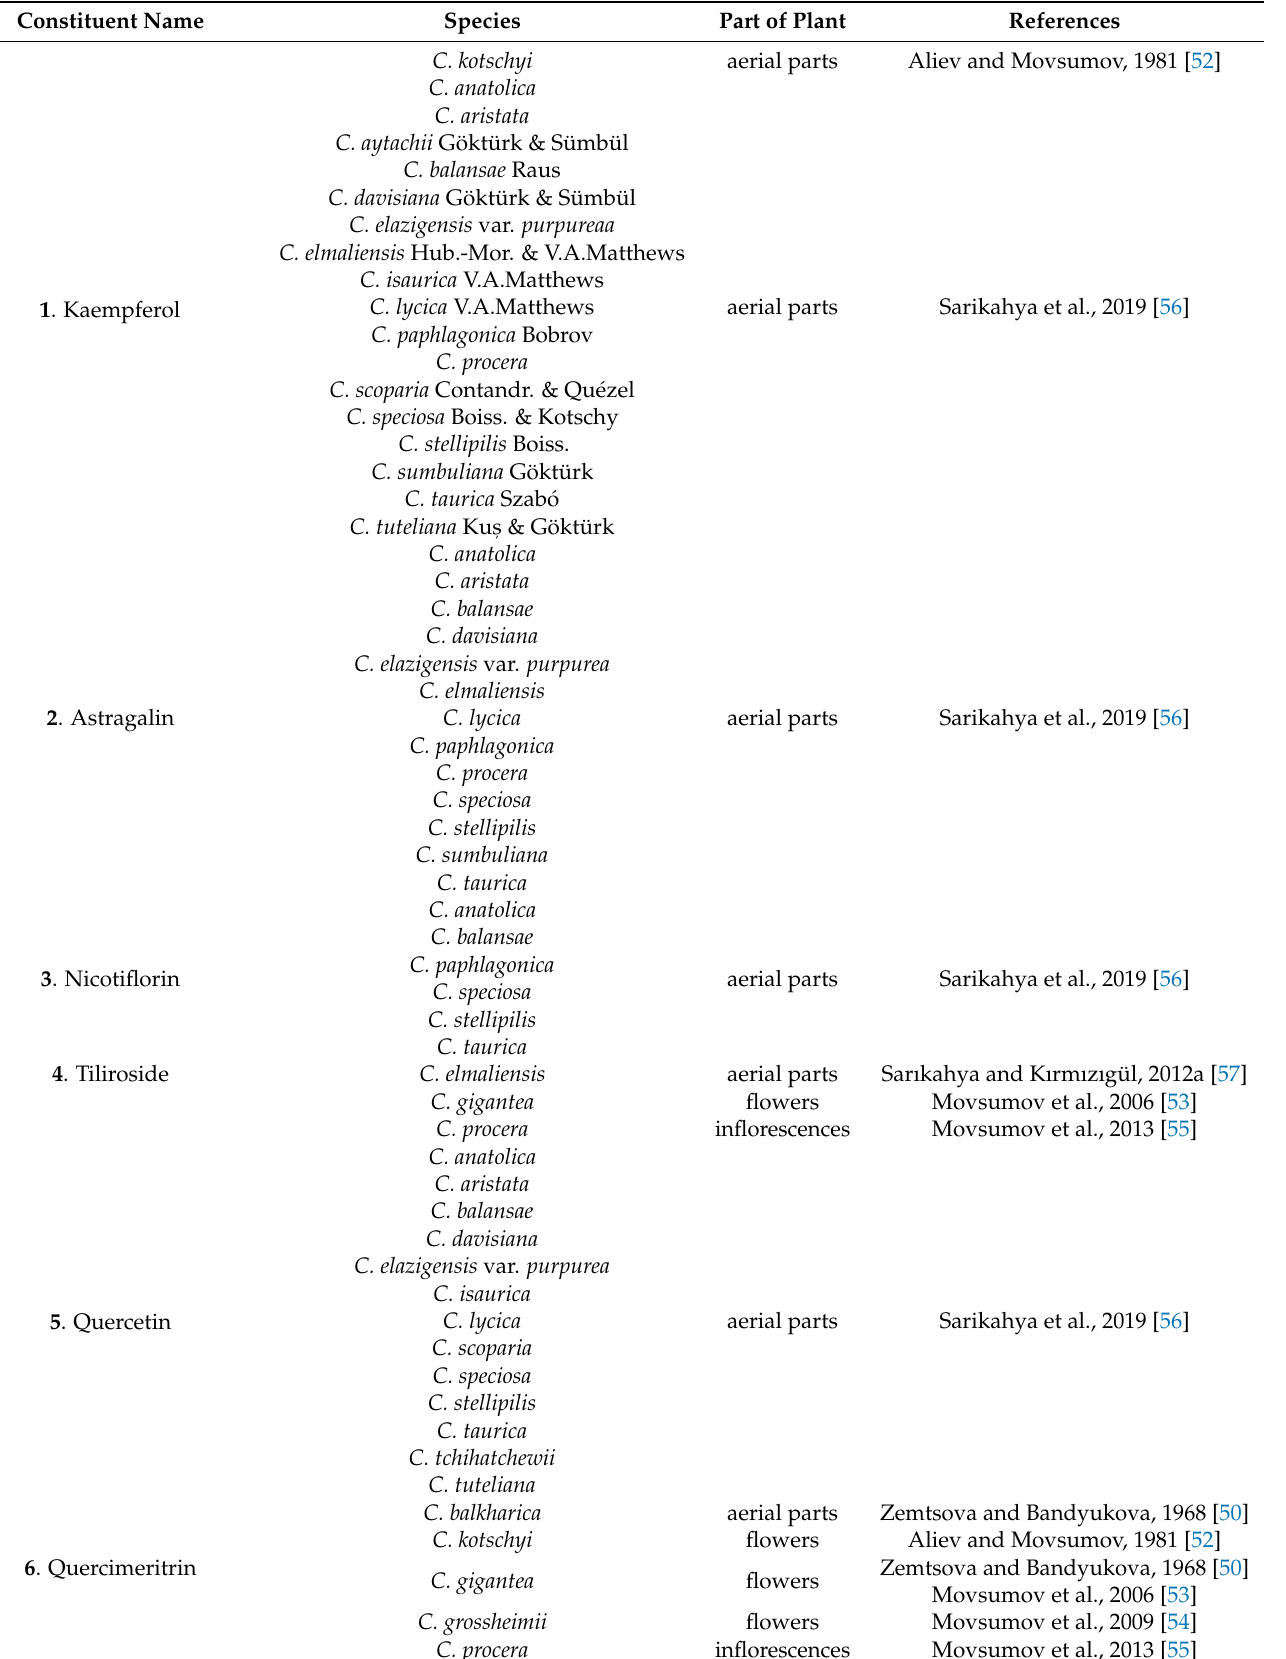
Table 1. The overview on the phenolic compounds identified in the Cephalaria